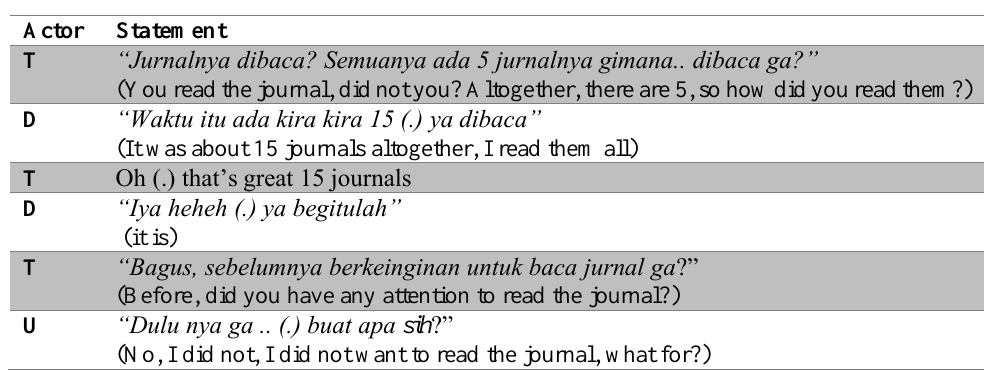
Table 7. Student’s interest in